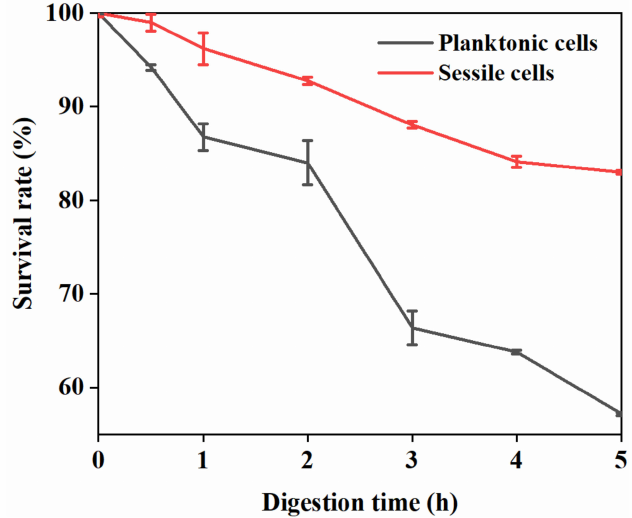
Figure 9. Survival rate of L. plantarum GIM1.648 in planktonic and biofilm modes after 5 h of digestion in a simulated gastrointestinal